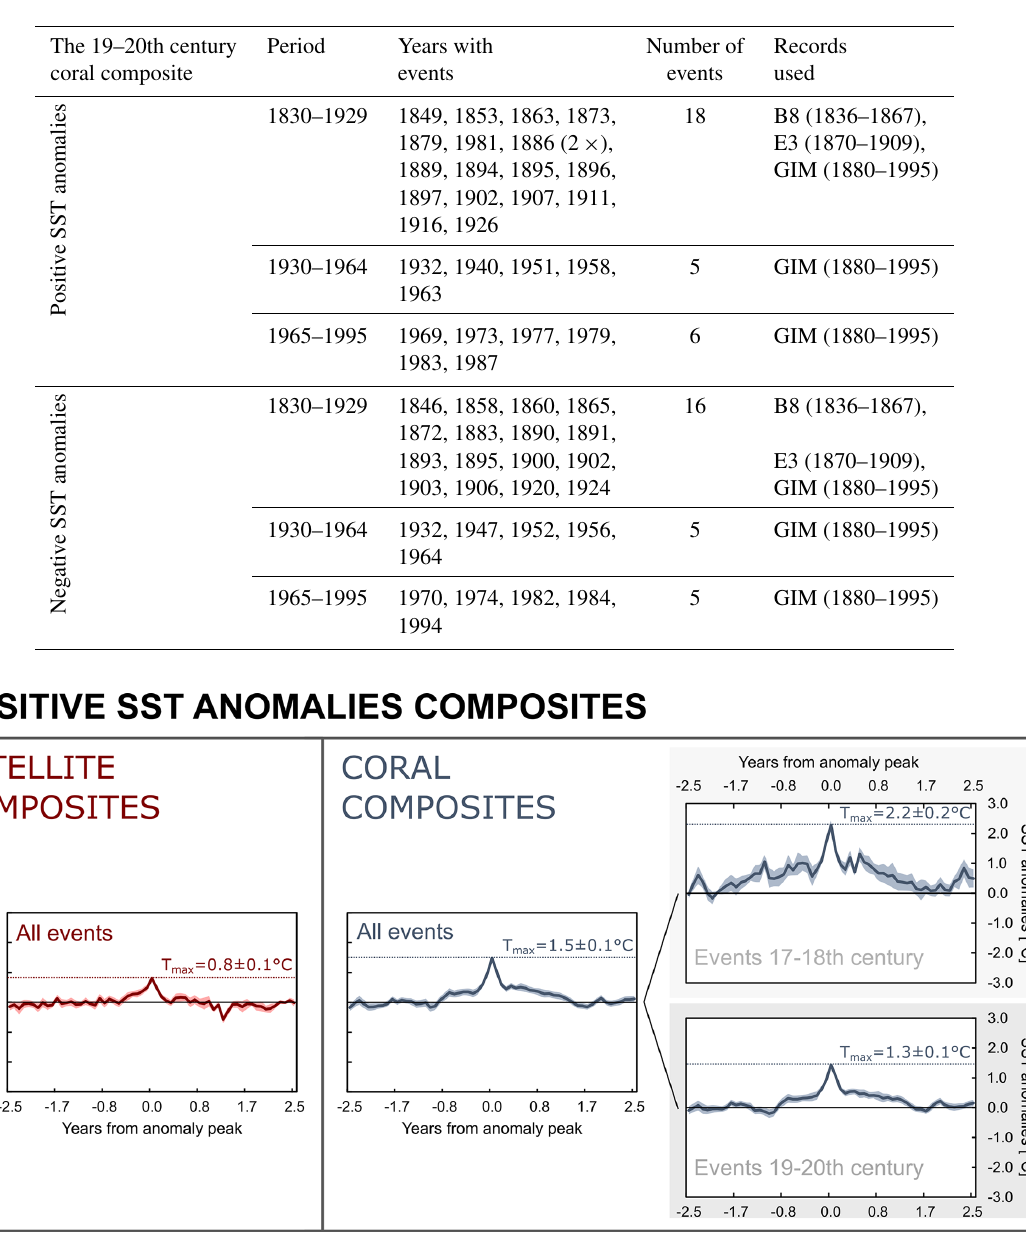
Figure 7. Positive SST anomaly (El Niño events) composite records of AVHRR (left; red) and coral SST (right; blue) records. Separate composites of anomaly events during the 17–18th and 19–20th century were generated from the coral SST records. Shaded areas below and above the curves show the standard error for the mean values of the composite records. See Table 4 for an overview of the events that were selected for generating the